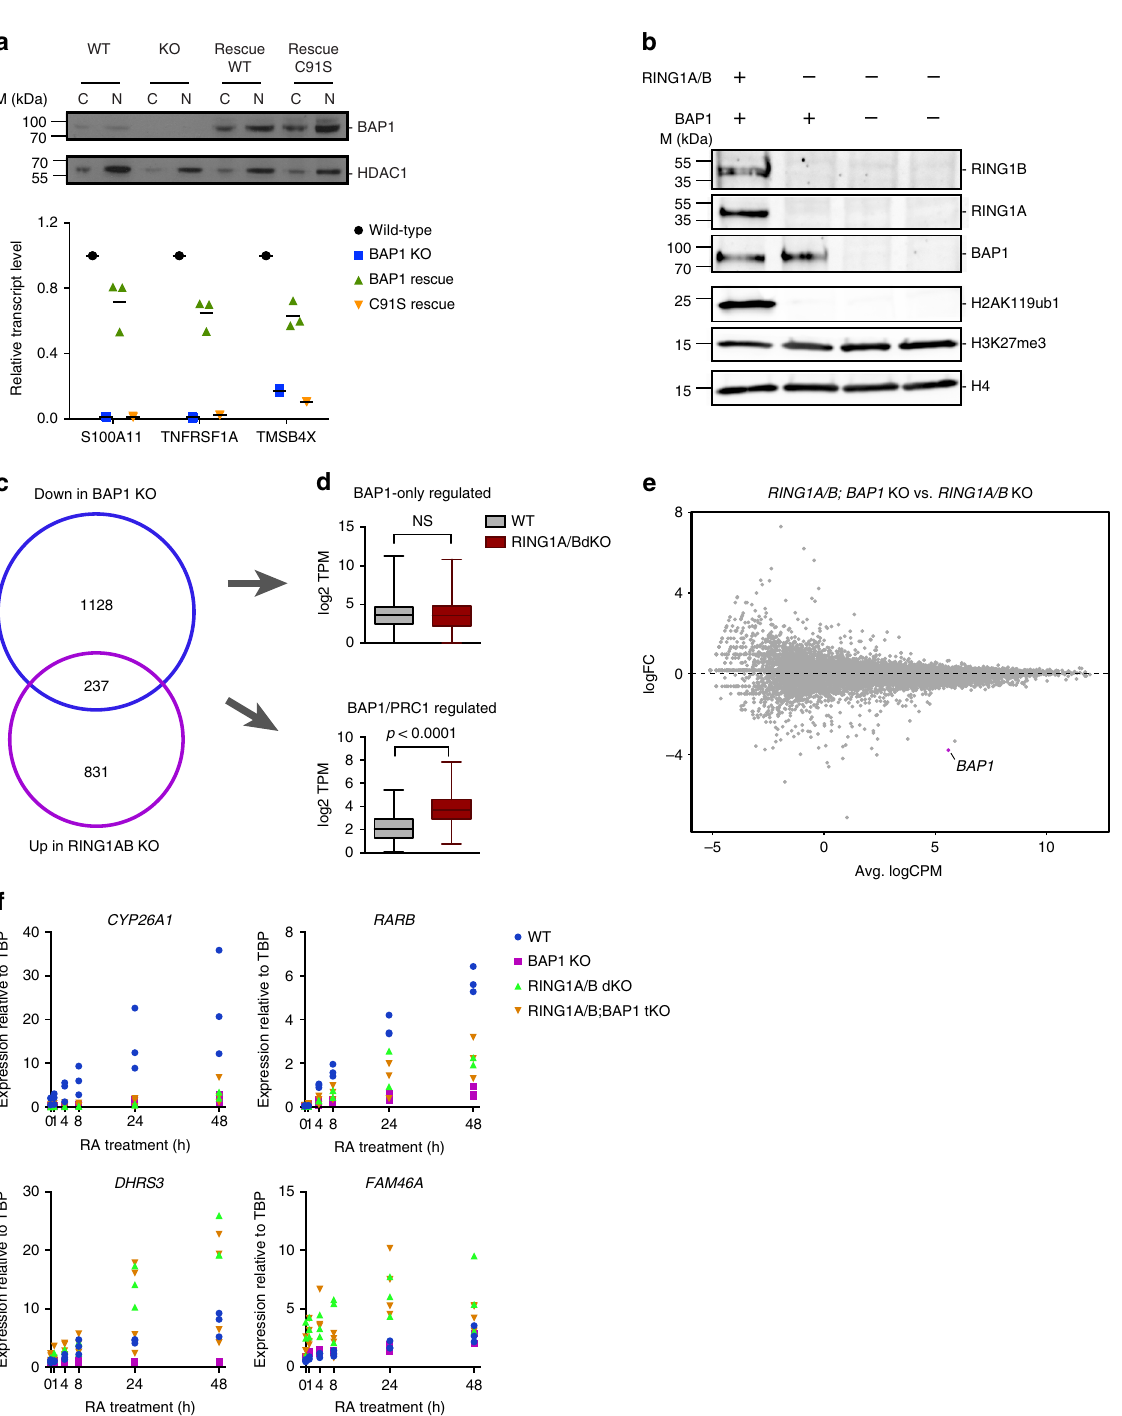
Fig. 6 BAP1 function relies on its deubiquitinase activity against H2AK119ub1. a Reintroduction of wild-type or catalytically dead (C91S) BAP1 in BAP1 KO cells. Top panel: western blot analysis of BAP1 expression in cytoplasmic (C) or nuclear (N) fractions. HDAC1 is used as a loading control. Bottom panel: RT-qPCR analysis of three BAP1-regulated genes in wild-type, BAP1 KO and the two rescue conditions. Horizontal bars indicate the mean expression. n = 3. b Western blot analysis of RING1A, RING1B, BAP1, H2AK119ub1, and H3K27me3 in wild-type, RING1A/B double KO, or RING1A/B ; BAP1 triple KO HAP1 cells. H4 is used as a loading control. c Venn diagram showing the overlap between genes downregulated in BAP1 KO or upregulated in RING1A/B dKO cells. d Box-plots (median, lower, and upper quartiles, lowest and highest values) of log2 transcript per million (TPM) expression values of BAP1-only- regulated genes (top) and BAP1/PRC1-regulated genes 61 in WT and RING1A/B dKO cells. P -value of the Mann – Whitney test on WT versus RING1A/B dKO comparison is indicated. e Scatterplot showing log2 fold-change (logFC) expression between RING1A/B dKO and RING1A/B; BAP1 tKO cells as a function of average log2 counts per million (logCPM). BAP1 , the only differentially expressed genes is highlighted in purple. f RT-qPCR analysis of CYP26A1 , RARB , DHRS3, and FAM46A expression following RA treatment at different time-points in wild-type or BAP1 , RING1A/B , RING1A/B;BAP1 KO